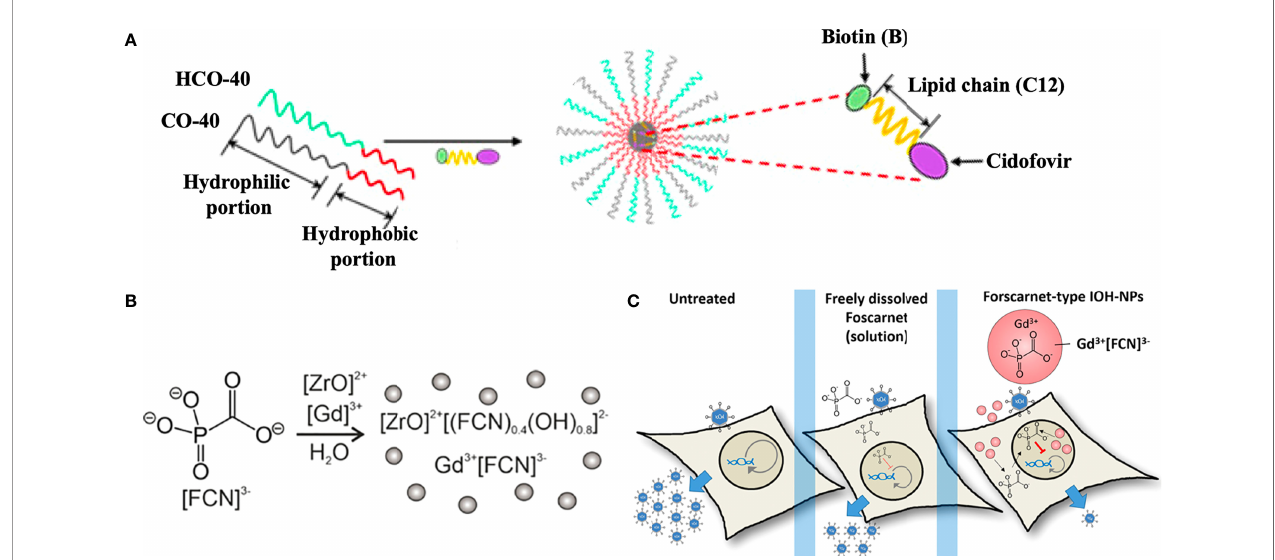
FIGURE 3 | Antiviral agents-encapsulated nanosystems. (A) Fabrication of a biotinylated lipid prodrug of cyclic cidofovir (B-C12-cCDF) within polymeric micelles. Reproduced with permission (Mandal et al., 2017). Copyright © 2017 American Chemical Society. (B) Fabrication of foscarnet (FCN)-, ZrO2+- and Gd3+-contained inorganic-organic hybrid NPs (IOH-NPs). (C) FCN-type IOH-NPs presented the promising antiviral activity for the delivery of antivirals against viruses. Reproduced with permission (Khorenko et al., 2022). Copyright © 2022, American Chemical